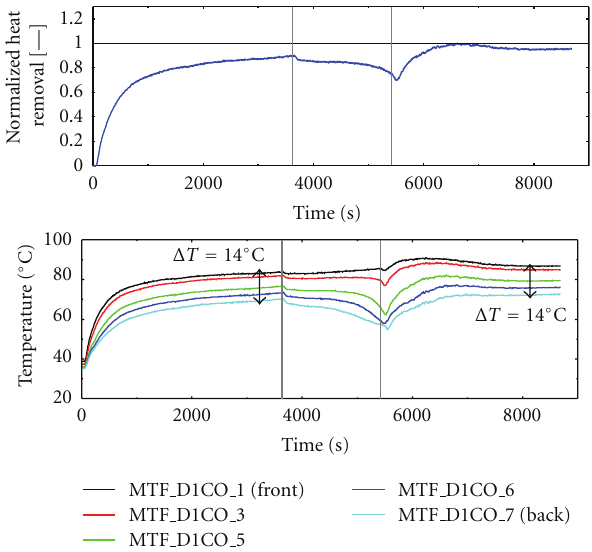
Figure 24: Normalized heat removal and water outlet temperature of the subchannels for experiment ST4